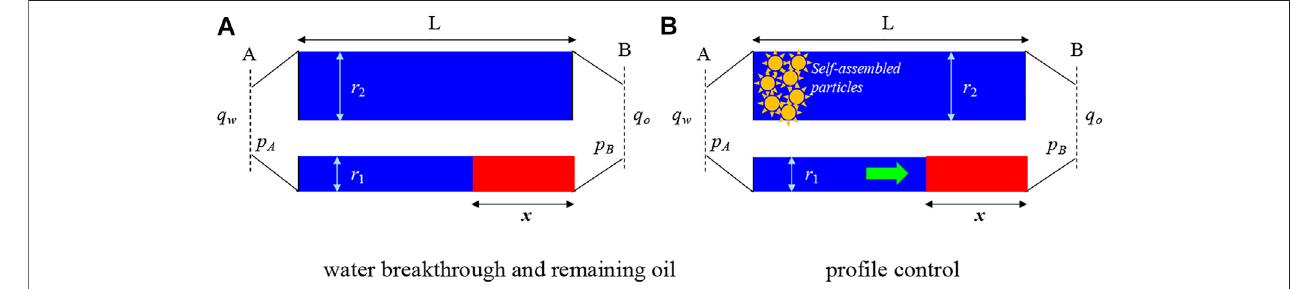
FIGURE 3 | Water breakthrough and pro fi le control.